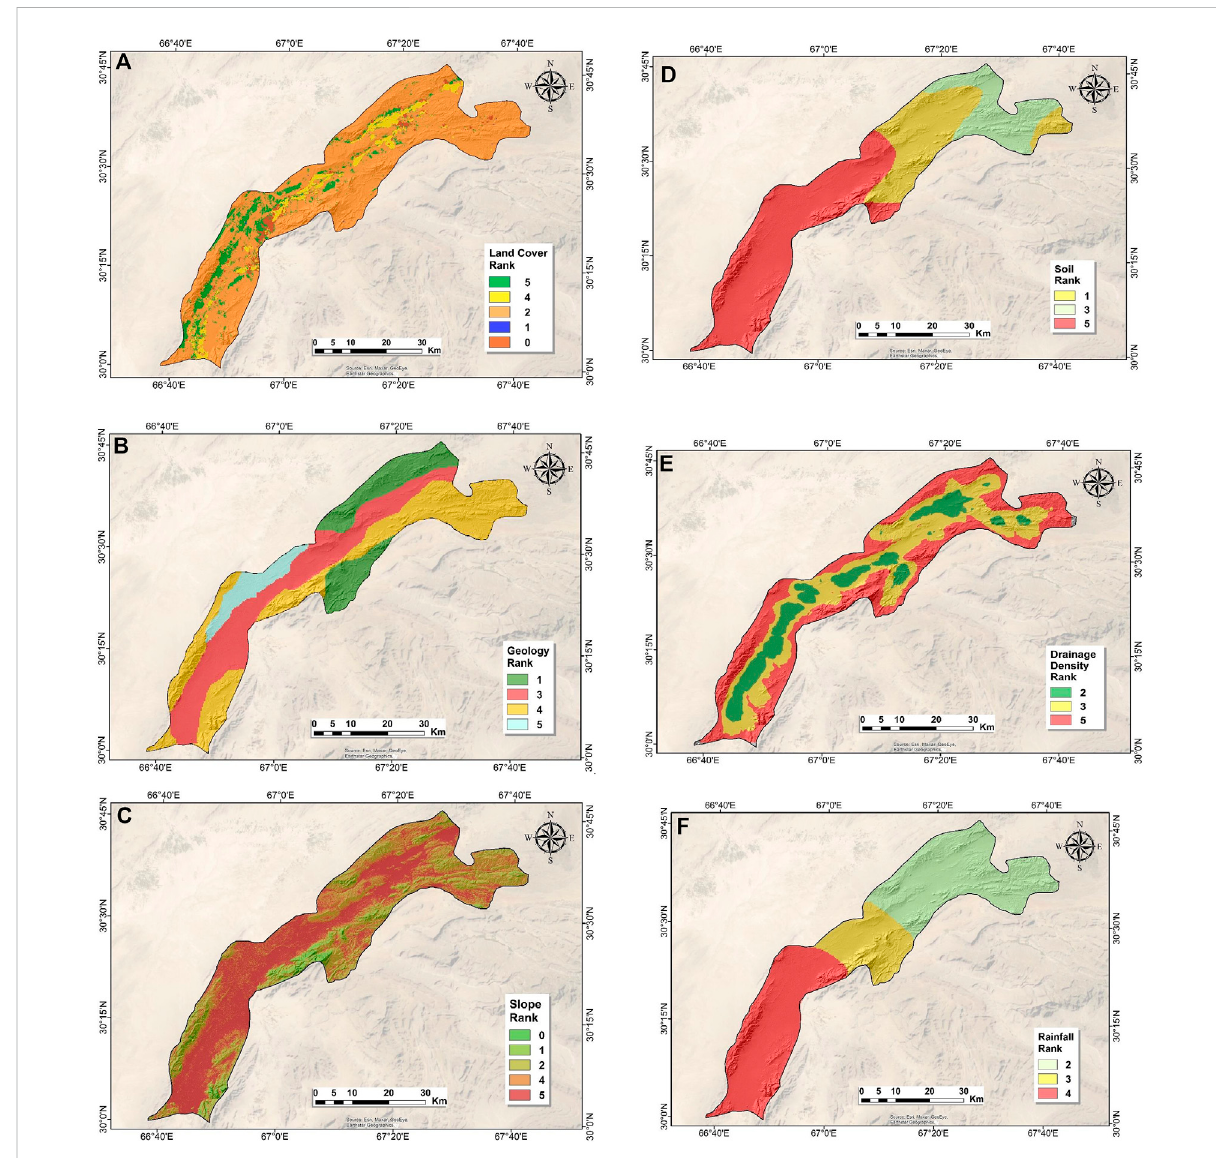
FIGURE 4 Criterion maps with standardized values used for the delineation ofsuitableMAR locations inthe Kuchlak Sub-Basin: (A) Land use; (B) Geology; (C) Slope analysis; (D) Soil type; (E) drainage density; (F) rainfall.